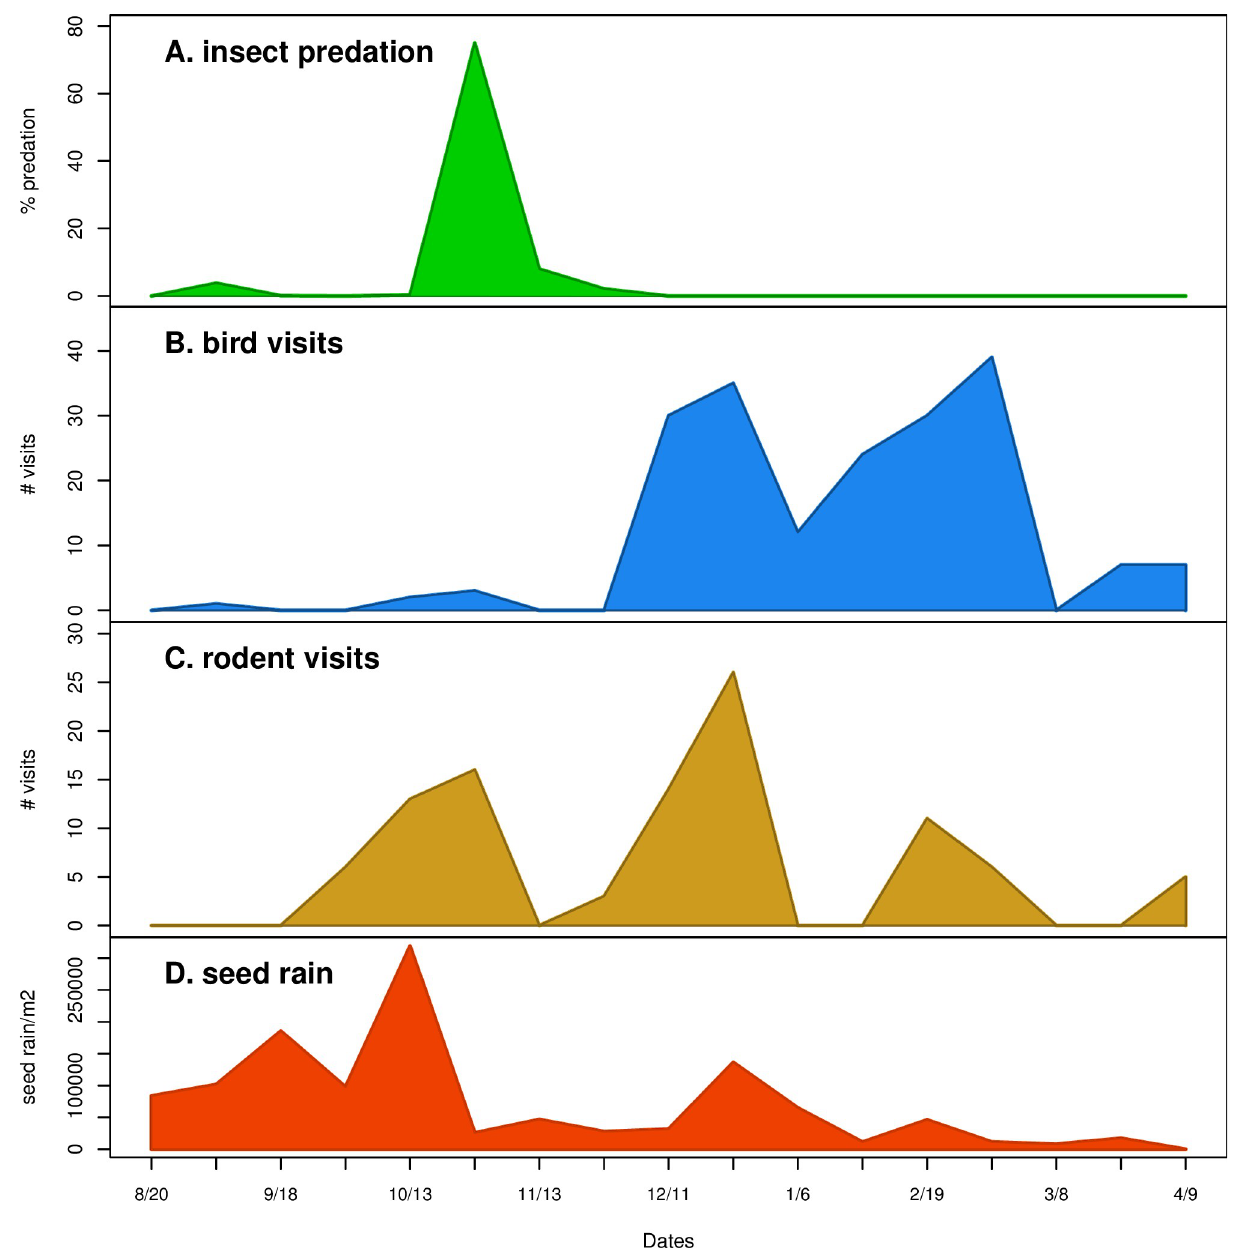
Fig 4. Temporal comparisons of a) insect; b) bird; and c) rodent visitations as captured by trail cameras or damage to seeds. These are in the context of d) the pattern of seed rain. Fires in this vegetation occur during the dry summer and overlap with the dispersal timing, typically peaking in